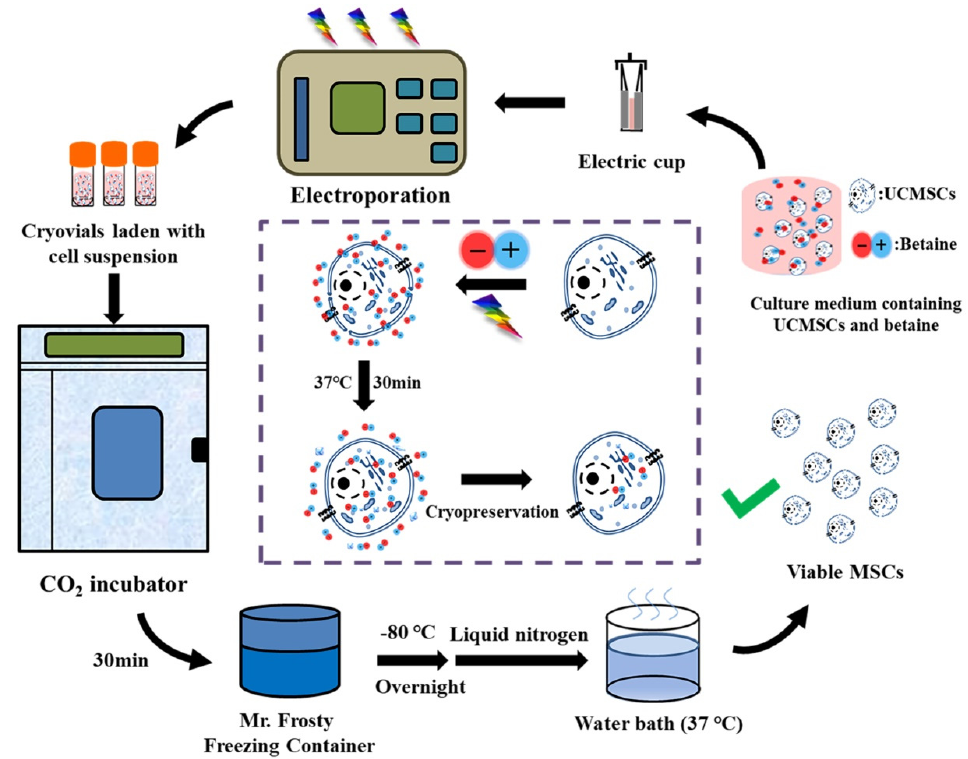
Figure 3. Procedure and proposed mechanism of UCMSCs cryopreservation by using betaine combined with electroporation.